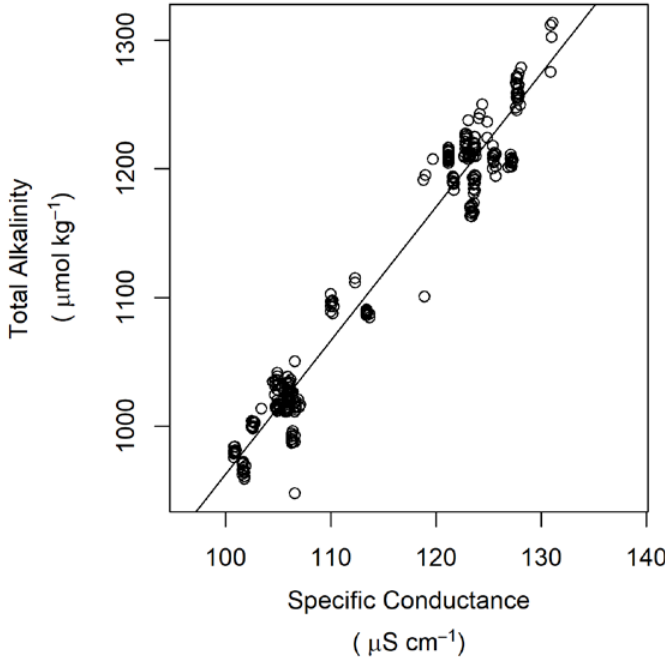
Figure 2. Relationship between specific conductance and total alkalinity for water samples obtained from this experiment. The linearity of this relationship allowed the calculation of total alkalinity (for carbonate system calculations) from higher frequency measurements of specific conductance.